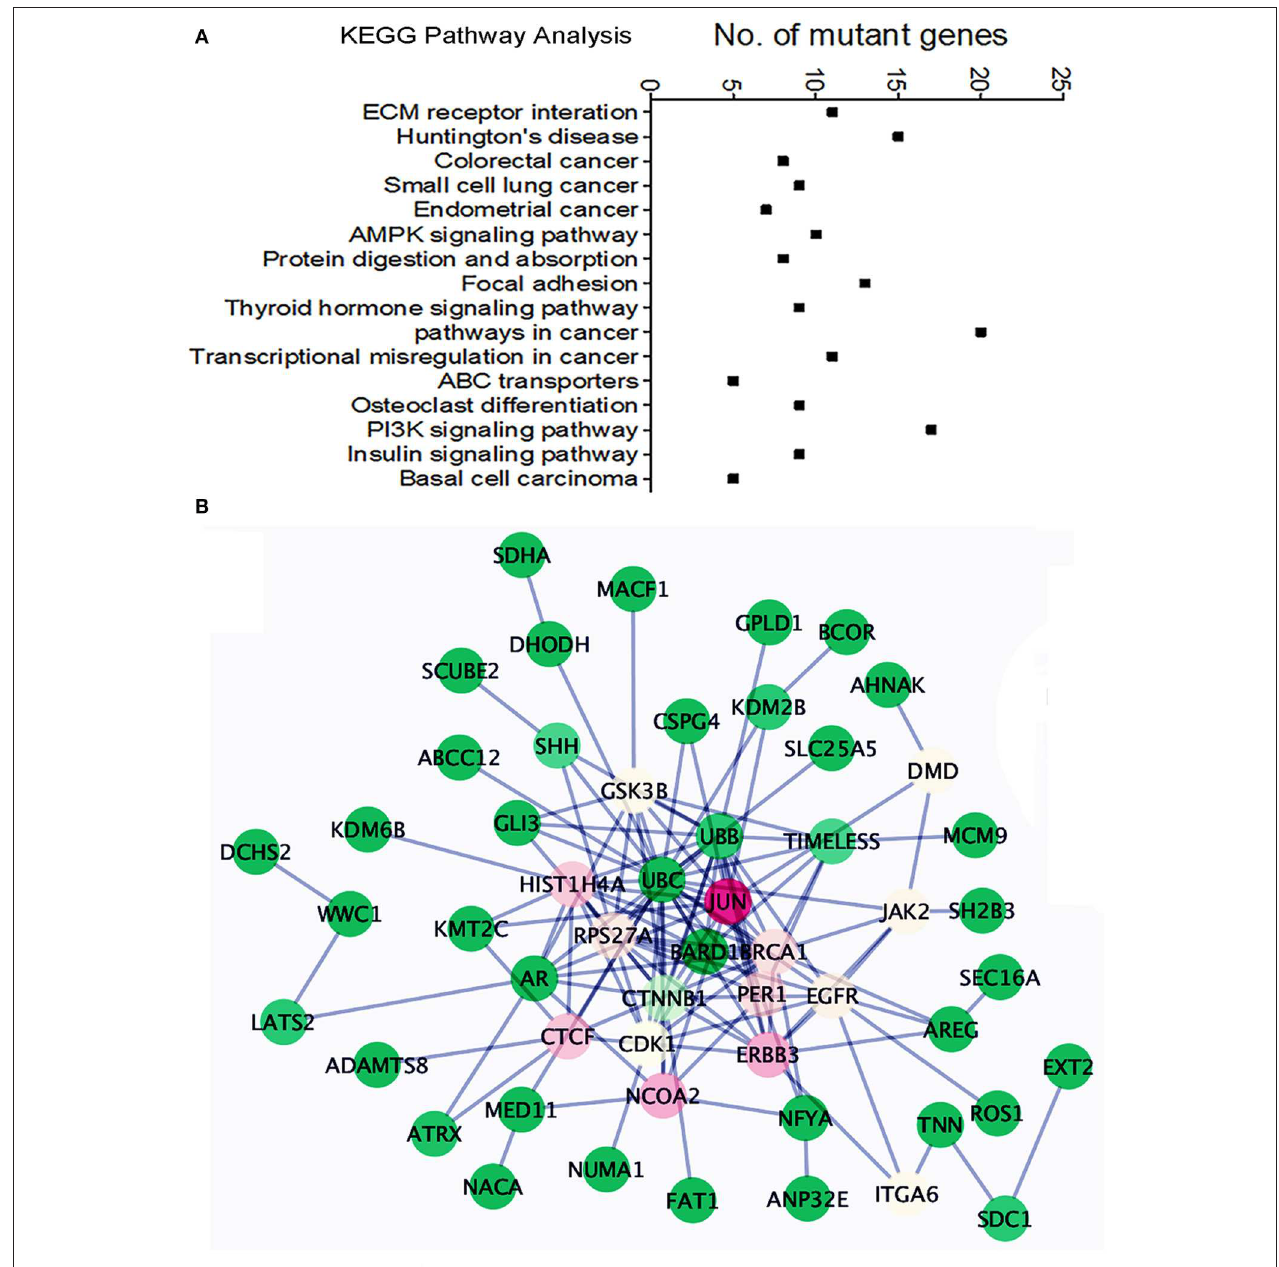
FIGURE 5 | Pathway analysis of the frequently mutated genes in Mullerian adenosarcoma (MAS). (A) Dot plot illustrates KEGG pathway analysis of oncogenes/tumor suppressor genes altered in MAS (for details, see text). (B) Schematic diagram illustrates the functional connections among 43 mutated genes. The color indicated the value of Betweenness Centrality (green = minimum, red =